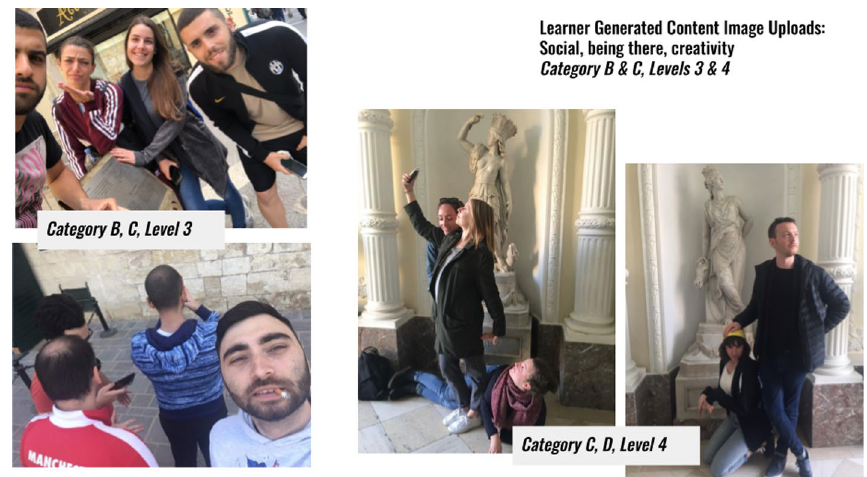
Fig. 3 LGC images reflecting Category B and C, Levels 3 and 4, then Category C and D, Level